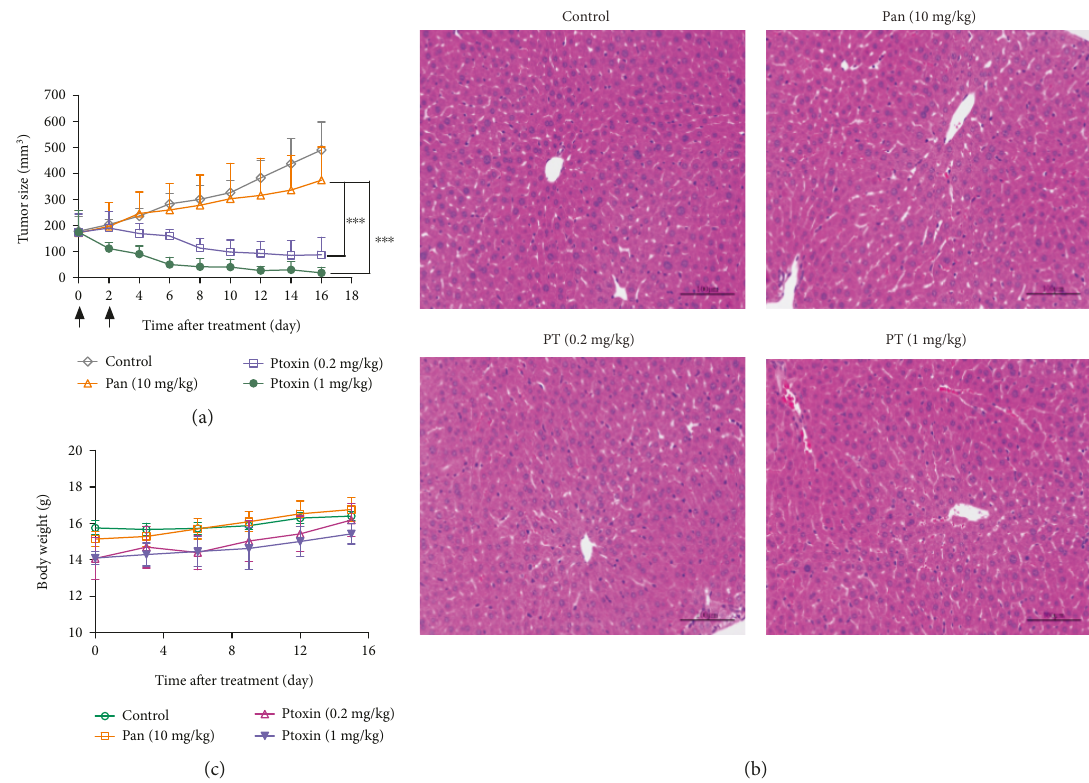
Figure 6: In vivo e ffi cacy of PT in the KYSE-450 xenograft tumor model. (a) Mean tumor volumes of mice xenografted with KYSE-450 cells and treated with PT. There were 6 mice per treatment group. PT treatment started as indicated in the graphs (black arrows). Error bars show ± SD ( ∗∗∗ p < 0 001 ). (b) Histological examination was conducted in nude mice post 2 weeks after the last injection with Pan or PT. Representative images (magni fi cation, × 400) of the liver from nude mice injected with indicated agents for two times were obtained by staining with hematoxylin and eosin. Scale bars: 100 μ m. (c) E ff ect of PT on nude mice body weight was determined using KYSE-450 tumor-bearing nude mice. Mice were weighed at regular intervals during the whole period to monitor therapy-related